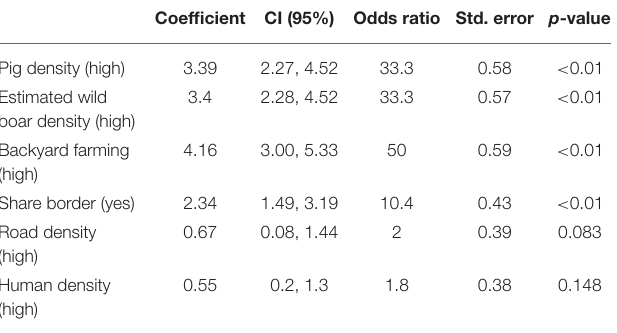
TABLE 5 | Association between selected epidemiological factors and risk for introduction of African swine fever (ASF) into a free country located in an infected region, as suggested by elicitation of expert opinion through a conjoint analysis